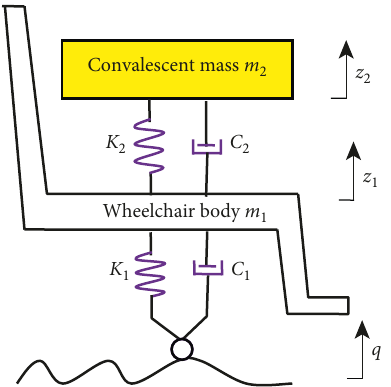
Figure 2: The vibration model of the convalescent-wheelchair system without